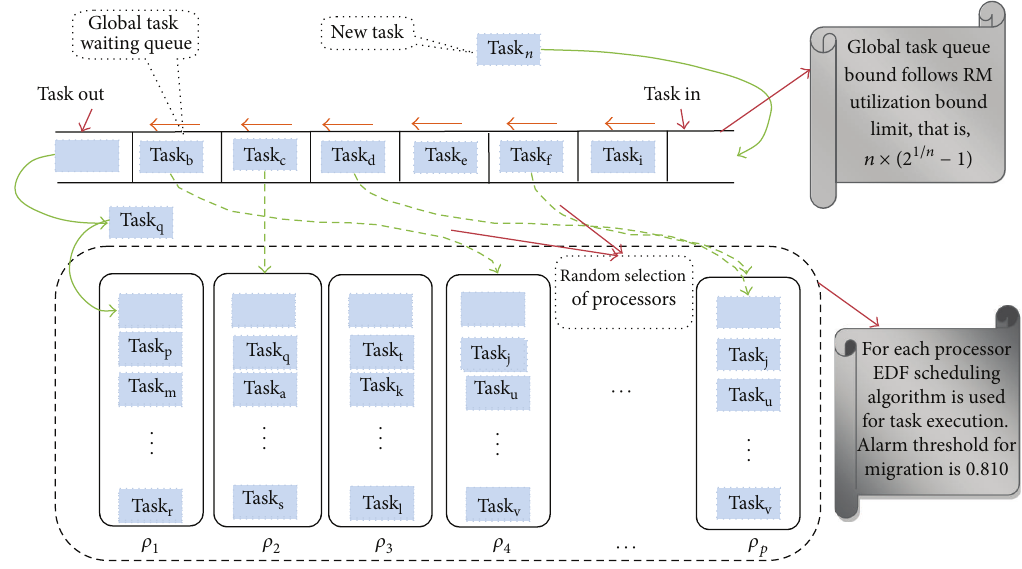
Figure 8: Architecture of proposed